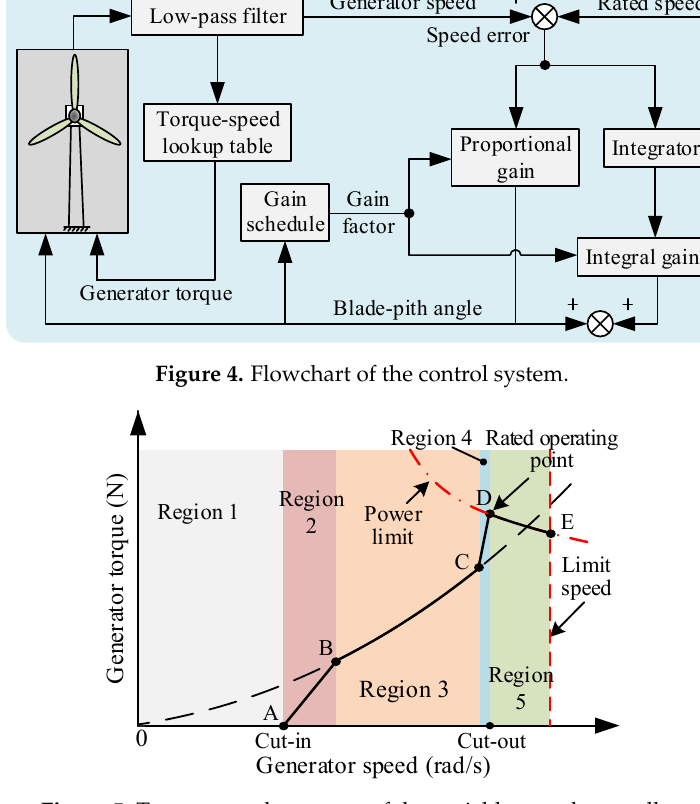
Figure 5. Torque-speed response of the variable-speed